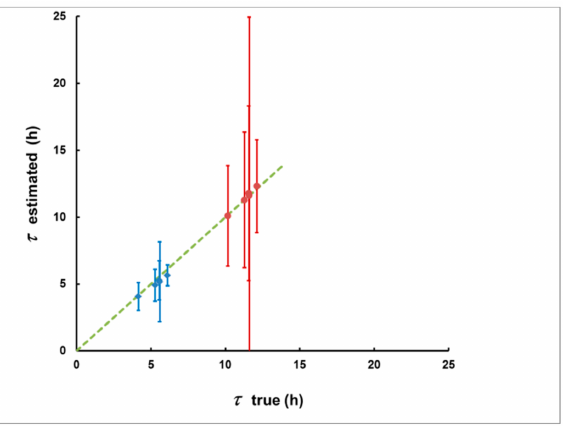
Figure 12. The estimated delays and their uncertainties due to the “counting statistics” (error bars) for the five plumes from Figure 11 and with the two delay scenarios (the first is in blue, the second is in red). Notably, the methodological bias (the deviation of the points from the dashed line that corresponds to the coincidence of the estimated and true delay) is much smaller than the statistical